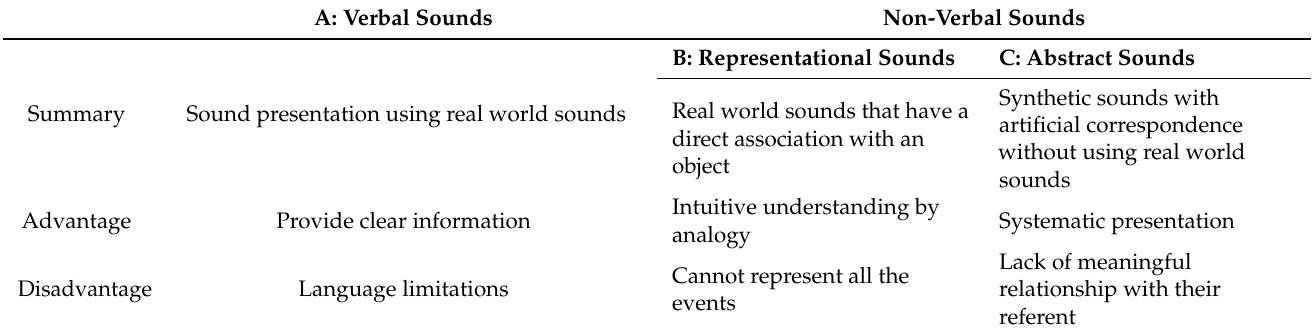
Table 2. The list of audio types using experiment.